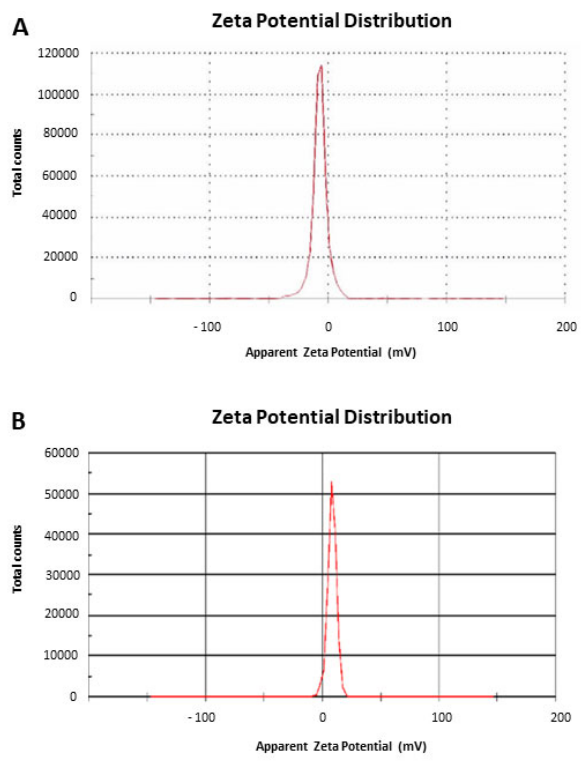
Figure 3. Zeta potential analysis of ( A ) AgNPs ( − 7.20 mV) and ( B ) CH-AgNPs (9 mV).